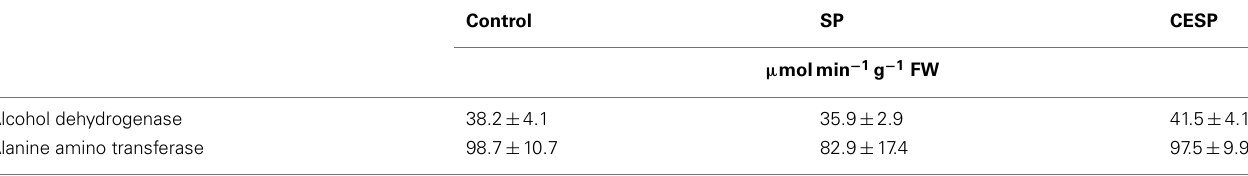
TableA2 |Assays of the key enzymes related to fermentation process following inhibition of 2-OGDHC by phosphonate analogous.